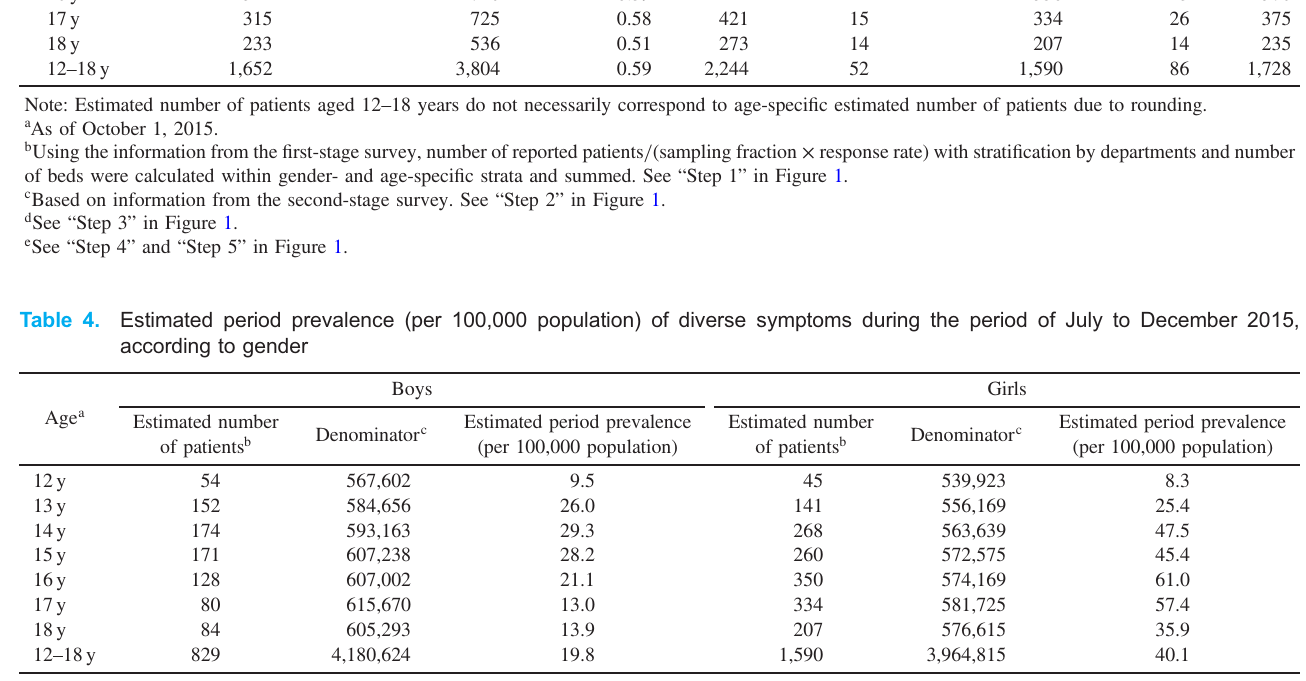
Reported number of Age a patients in fi rst-stage survey